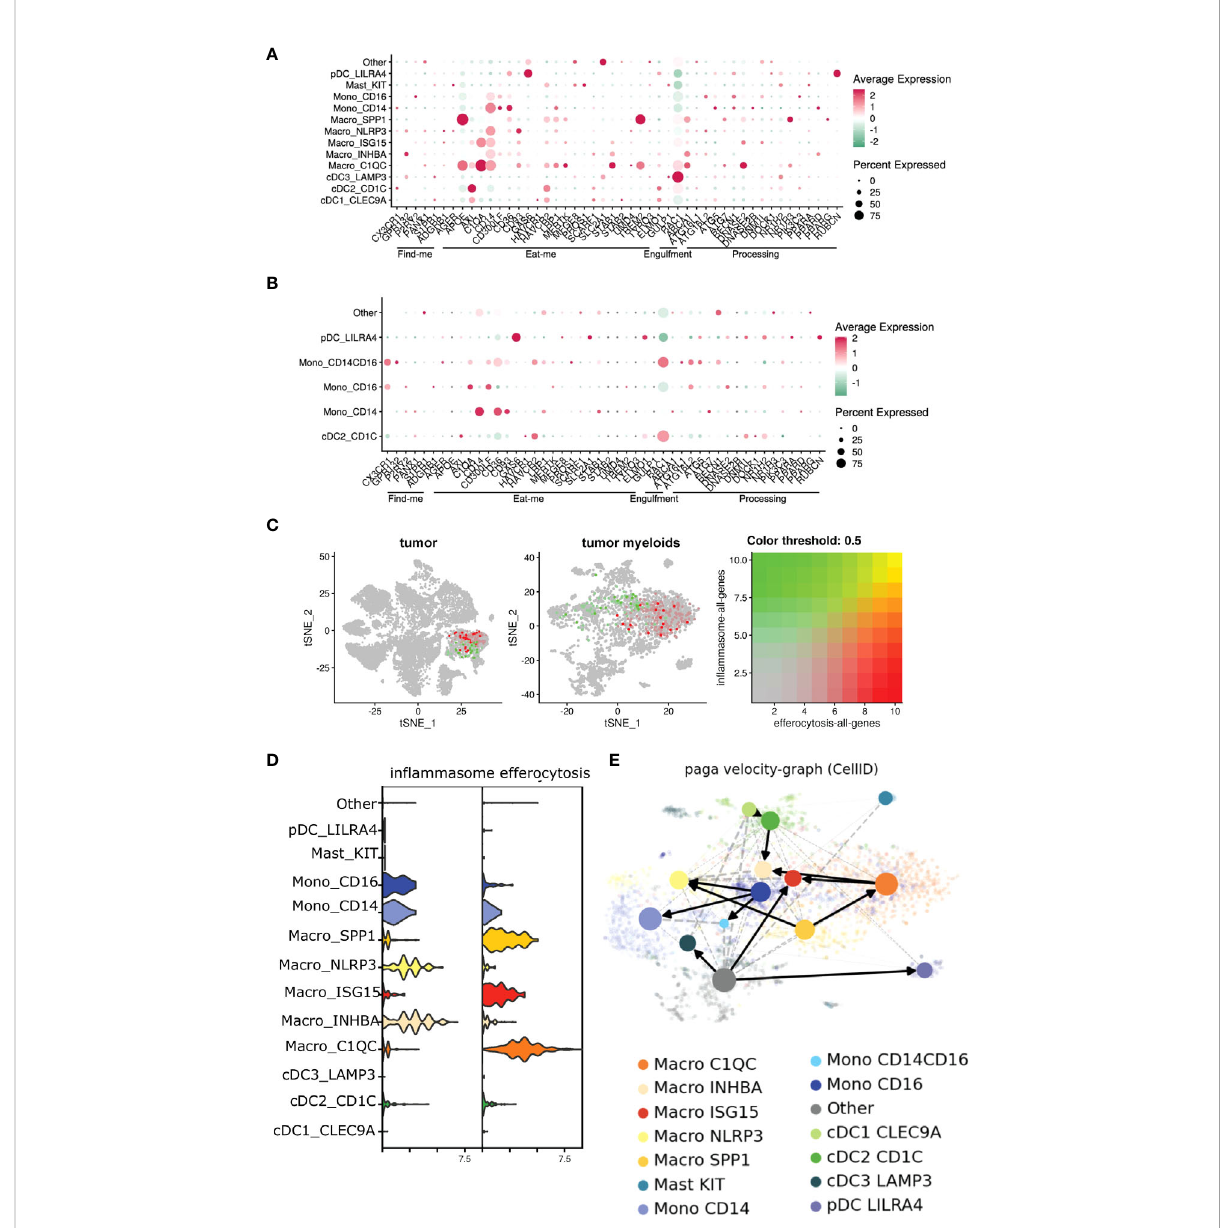
FIGURE 6 Efferocytosis gene atlas is enriched across single cell myeloid subsets in tumor and can potentially develop into in fl ammasome rich macrophages in the TME. (A, B) Single cell dataset from HNSCC patients was analyzed for genes associated with efferocytosis pathway in the myeloid subsets (n=6). Bubble heat map showing relative expression pattern of several efferocytosis genes across various myeloid subsets in the tumor (A) compared to matched blood (B) . (C) Feature plot shows in fl ammasome and efferocytosis pathway associated genes across different myeloid subsets within the tumor are not transcriptionally enriched in similar clusters. (D) Representative violin plot highlighting efferocytosis and in fl ammasome genes are enriched differentially in distinct myeloid subsets within the tumor. (E) Developmental trajectory of monocytes and macrophages enriched in the tumor indicate efferocytosis rich C1QC + and SPP1 + macrophages can potentially develop into in fl ammasome gene rich INHBA + and NLRP3 + subsets respectively in the TME. Cells are colored according to their cluster